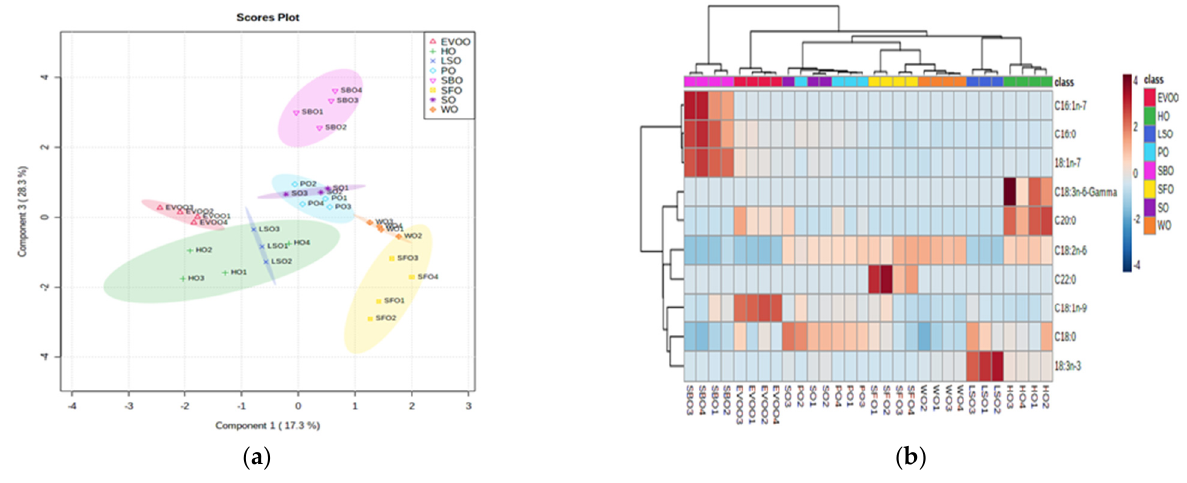
Figure 1. ( a ) The PLSDA score plot for the discriminatory analysis of the eight classes of oils. ( b ) The heatmap illustrating the individual fatty acids to be considered potential biomarkers of each oil group. Table 2. Mean values and standard deviations (x ± SD) representing the percentages of saturated (SFA), monounsaturated (MUFA), polyunsaturated (PUFA) fatty acids identified in each type of oil. The ratios PUFA/MUFA and MUFA + PUFA/SFA (unsaturation index) are presented in columns 5 and 6, respectively. For oil abbreviations, see Table 1.